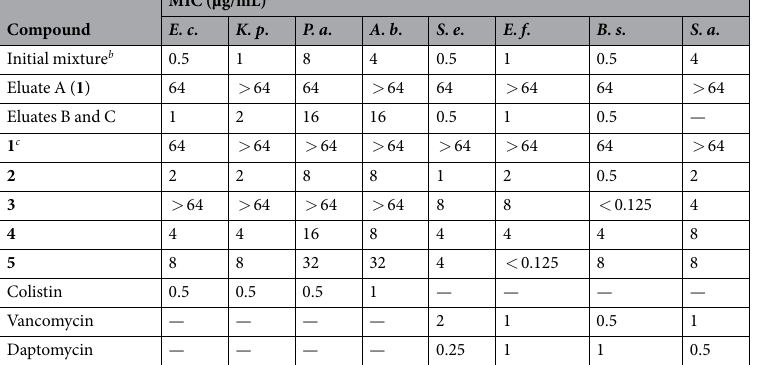
Table 3. Minimum Inhibitory Concentration (MIC) of compounds 1 – 5 , eluates A, B and C and control antibiotics (colistin, vancomycin and daptomycin) against representative strains of Gram-positive and Gram- negative bacteria. -.: not determined. a MICs are expressed as median values calculated from experiments performed at least in triplicate. Tested bacterial strains: E.c.: E. coli CCUG T ; K. p.: K. pneumoniae ATCC